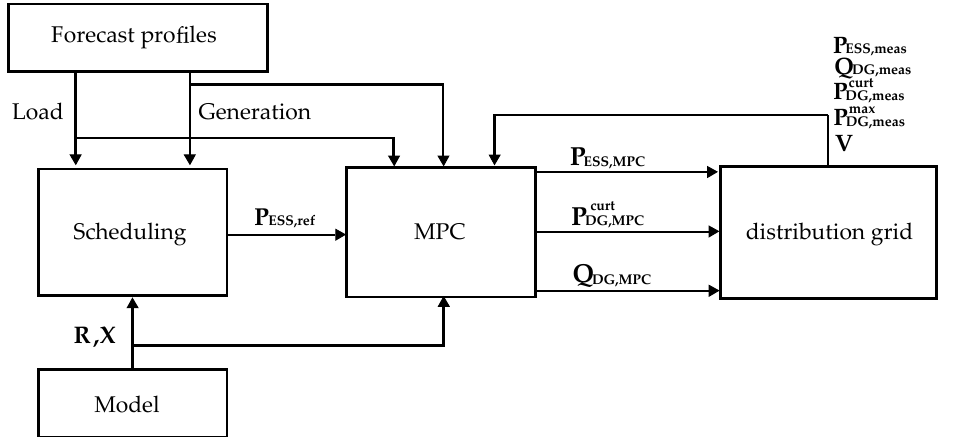
Figure 16. Control structure for Test 3.